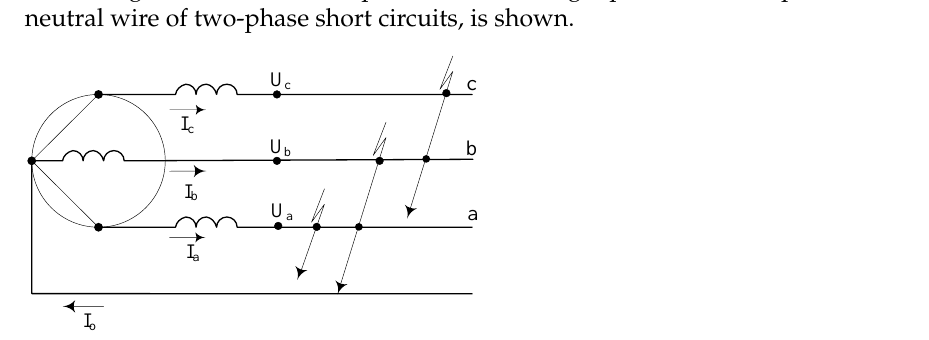
Figure 2. The scheme of single-phase, two-phase, and also the neutral wire of two-phase short circuits.